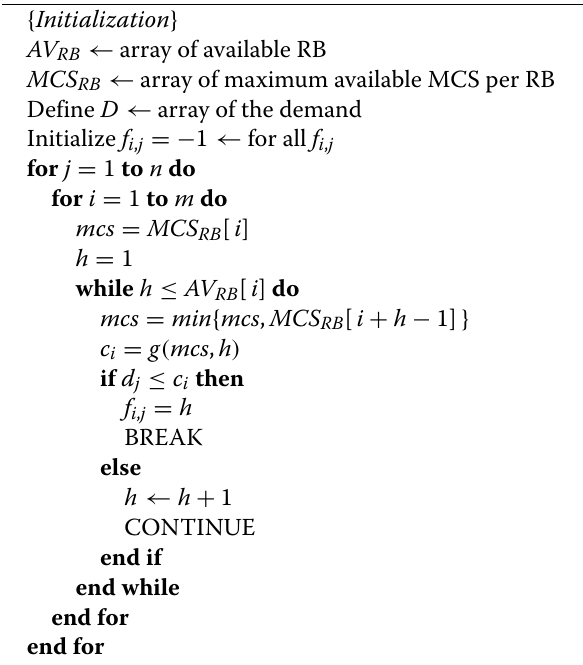
Algorithm 1 algorithm to create f i ,